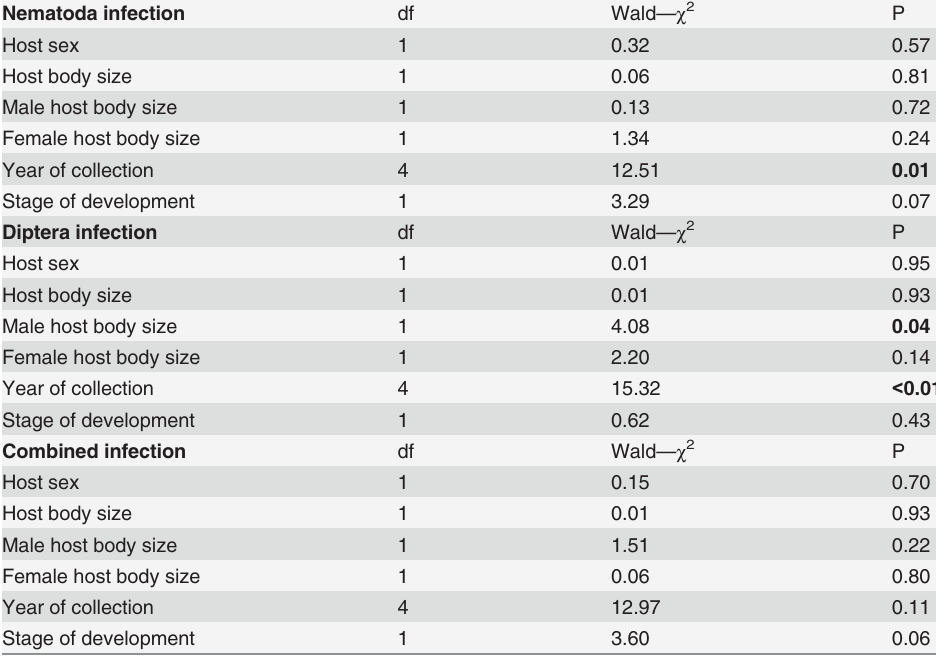
Table 2. Generalized Linear Model results of ecological correlates of infection by dipteran and nema- tode